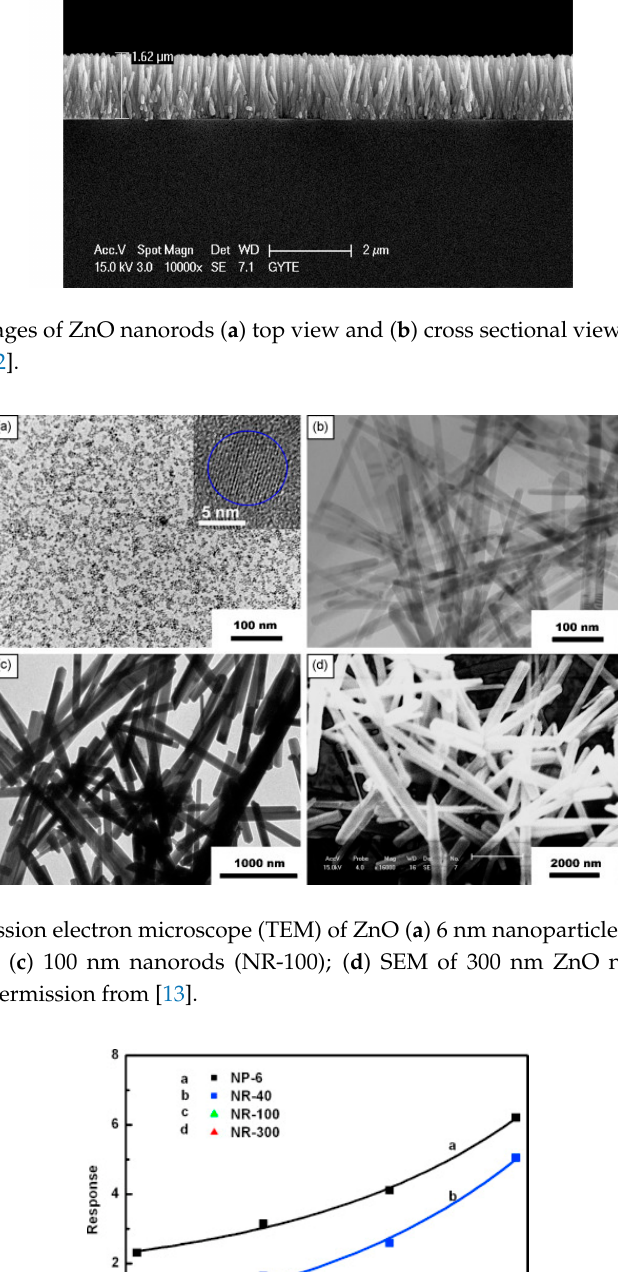
Figure 32. Transient photovoltage (TPV) of ( a ) NP-6; ( b ) NR-40; ( c ) NR-100; and ( d ) NR-300 under 355 nm light irradiation. Reproduced with permission from [13]. 2.2.3. Nanofibers Nanofiber structures have been synthesized and investigated for light-activated gas sensors [14,62]. Gong fabricated ZnO fiber sensors to detect toluene, benzene, acetone and ethanol at room temperature under UV irradiation [14]. Zampetti synthesized titania nanofibers with diameters around 50 nm by electrospinning and evaluated their sensing response towards NH 3 , NO 2 and humidity at room temperature under UV LED illumination. The nanofibers show better sensing selectivity to NH 3 and the sensing response is 2.8 towards NH 3 with very low concentration of 200 ppb [14]. 2.2.4. Summary In this section, we have summarized the one-dimensional nanostructures used in the conductometric gas sensor activated by light. One-dimensional nanostructures including nanowires, nanorods and nanofibers have been reported for gas sensing usage. Whilemost the reported efforts were based on metal oxides nanotubes and nanoribbons, the use of nanotubes and nanoribbons for gas sensor with light activation has received much less attention. It is obvious that this direction should be investigated more. 2.3. Metal Oxides with Porous Nanostructures